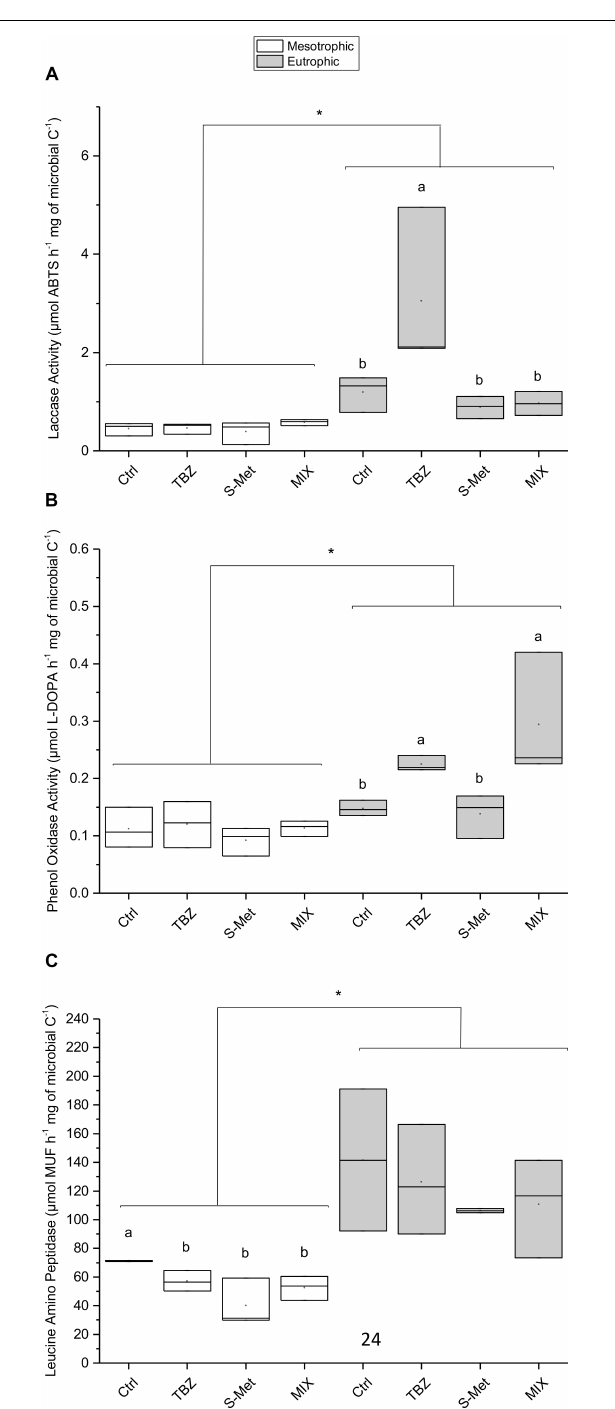
FIGURE 2 | Integrated extracellular specific laccase (A) , phenol oxidase (B), and leucine aminopeptidase activities (C) measured in experimental stream channels exposed to fungicide (TBZ), herbicide (S-Met), both fungicide + herbicide (MIX) or non-exposed (Ctrl), in either mesotrophic (white fill) or eutrophic (gray fill) nutrient condition. Values are median + quartiles 1 and 3 ( n = 3). Differences between nutrient conditions are represented by an asterisk (Kruskal–Wallis, P < 0.05) whereas differences between treatments are represented by subscript (a >